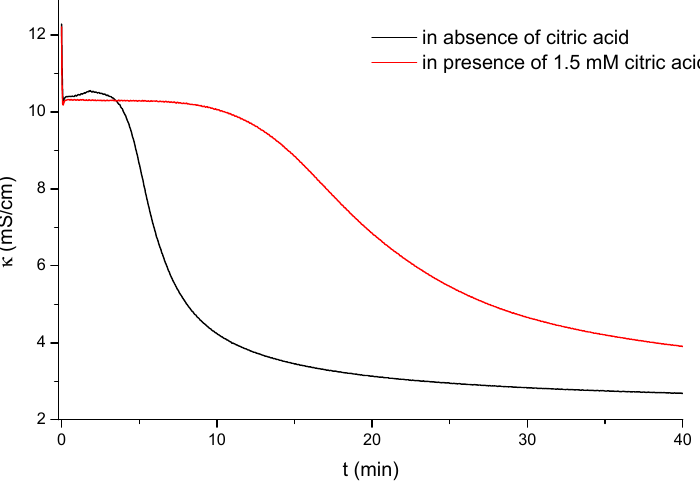
Figure 1. Variation of solution conductivity during the reaction of MgSO 4 + Ca(OH) 2 + 2 H 2 O → Mg(OH) 2 + CaSO 4 · 2H 2 O with identical (0.1 M) initial reactant concentrations in the absence and in the presence of 1.5-mM citric acid (T = 20 °C; in distilled water media without any supporting electrolyte).